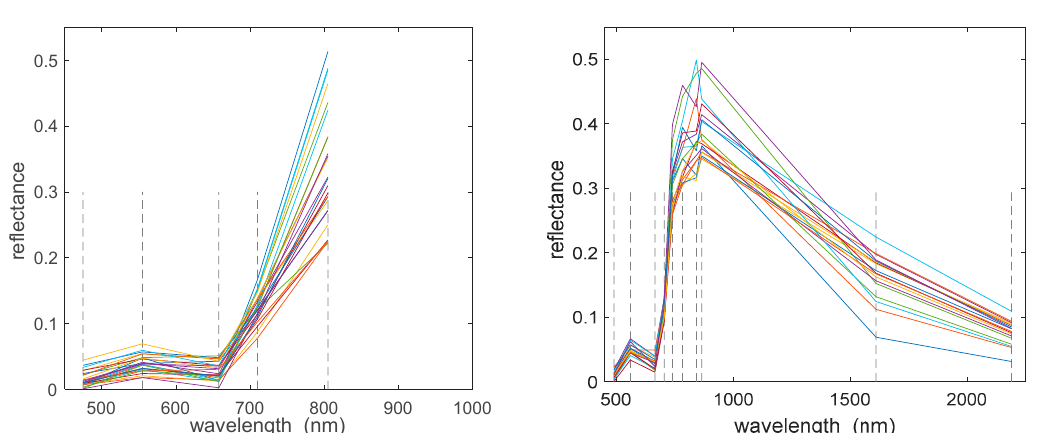
Figure 3. Reflectance of the measured plots in Schiermonnikoog island, The Netherlands. Extracted from, RapidEye in 2015 (n = 30) and Sentinel-2 in 2016 (n = 20), respectively. The broken lines show the centre positions of the spectral bands of the